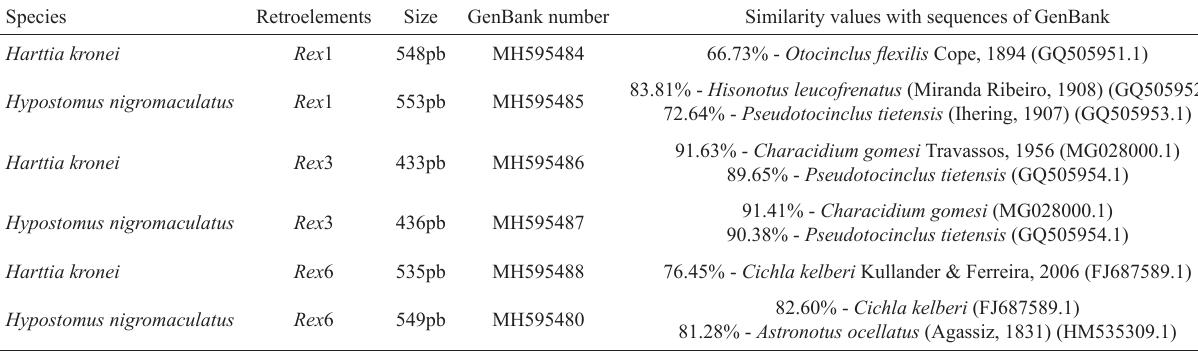
Tab. 2. Retroelements obtained in the present